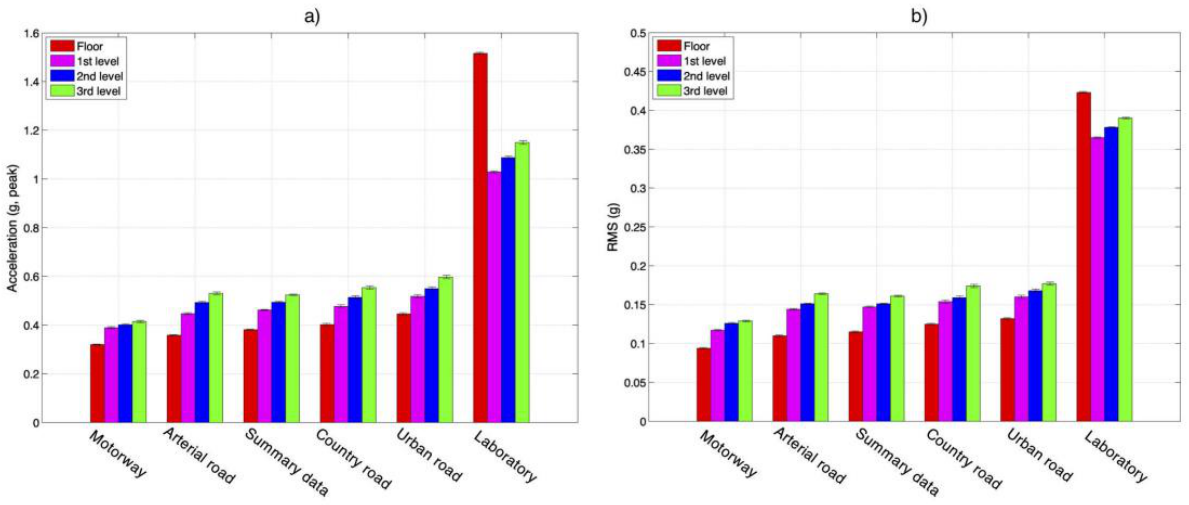
Figure 6. ( a ) Peak acceleration and ( b ) RMS acceleration values of the stacked unit and floor on different road conditions. There were no statistically significant differences at acceleration peaks between the 1st and 2nd level for the motorway; between arterial road and country road at acceleration peaks and RMS acceleration values for the 2nd level; between the 2nd and 3rd level of RMS acceleration for the motorway ( p < 0.05). In the laboratory, the acceleration values on the platform were 1.31–1.48 times higher than those measured in the upper levels of the stacked unit. However, in the field measurements, the acceleration values on the floor were 0.72–0.82 times lower than in the higher levels. This can be seen in the summary data. In terms of summary data for stacked unit levels the acceleration values were 1.21,